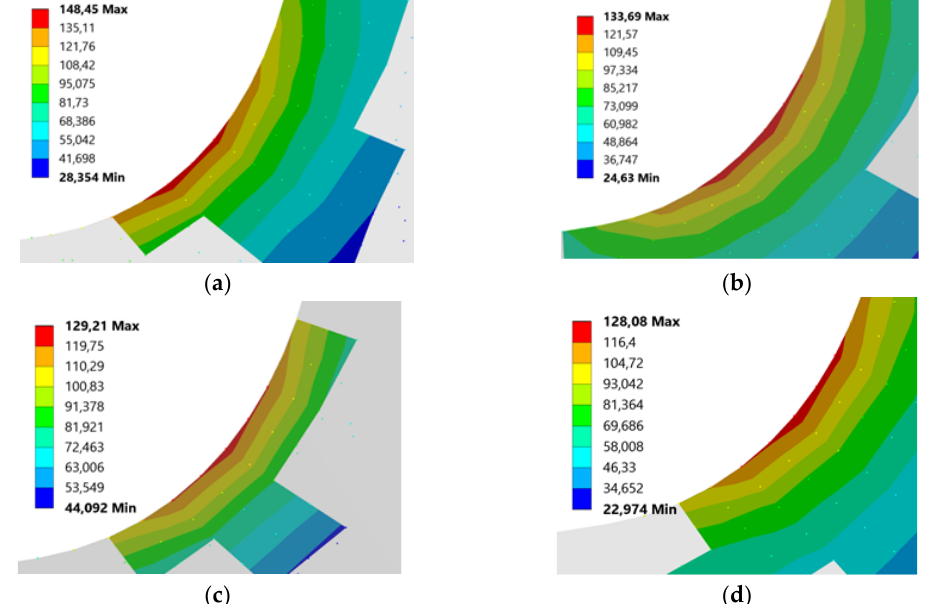
Figure 17. Root stress results for hybrid gears with α d = 25° for different RTs; ( a ) 0.5 xm, ( b ) 1 xm, ( c ) 1.5 xm, ( d ) 2 xm.